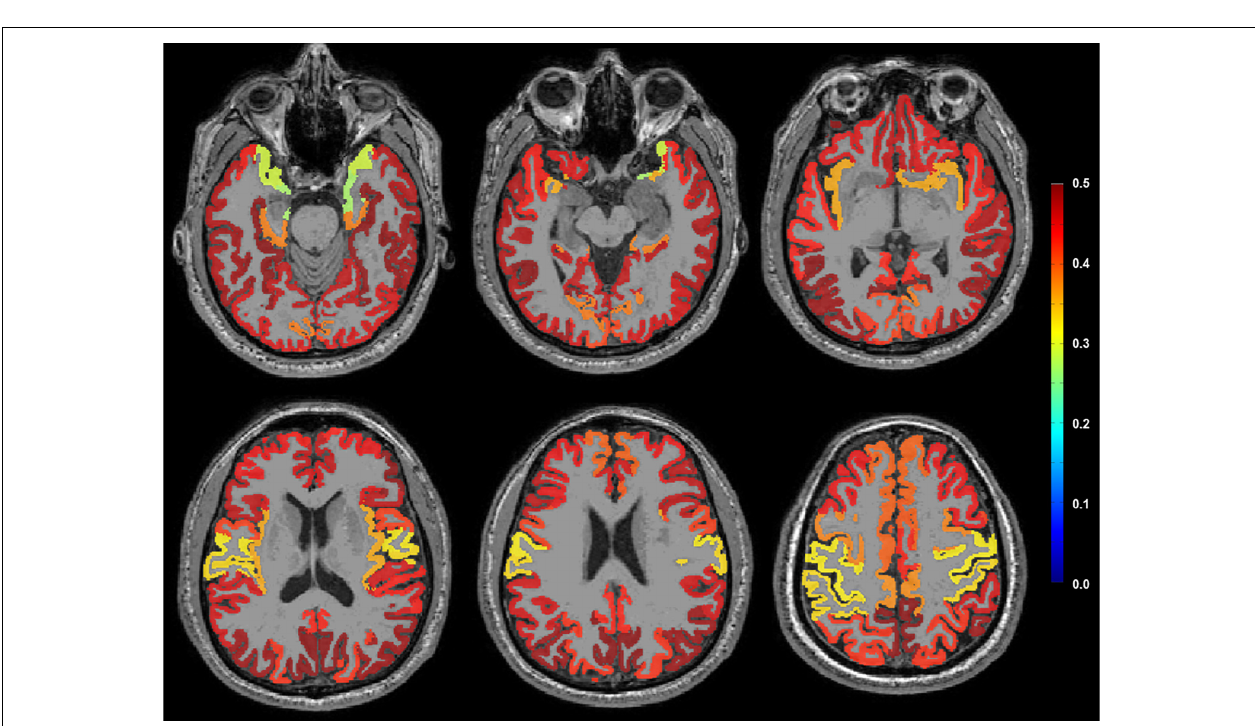
FIGURE 3 | Correlation coefficient ( r ) between plasma A β 42 / 40 and amyloid PET SUVR on representative MRI using pattern analysis. A moderate positive correlation (red color) was observed in the bilateral frontal, parietal, temporal, and occipital cortices, except the primary motor and sensory cortices. A β , amyloid- β ; SUVR, standardized uptake value